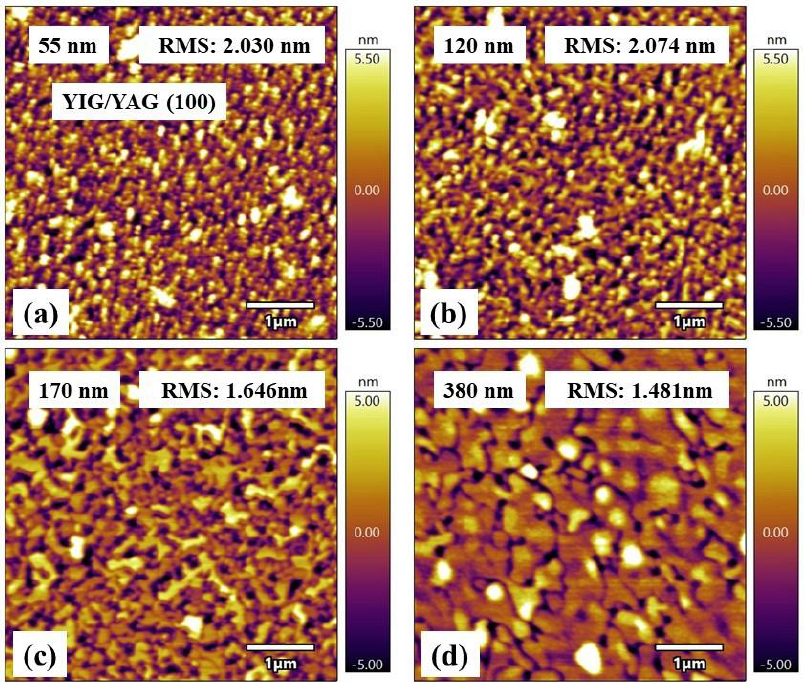
Figure 2. AFM topography images for YIG films of thickness ( a ) 55 nm, ( b ) 120 nm, ( c ) 170 nm, and ( d ) 380 nm on (100) YAG. ( d ) 380 nm on (100)